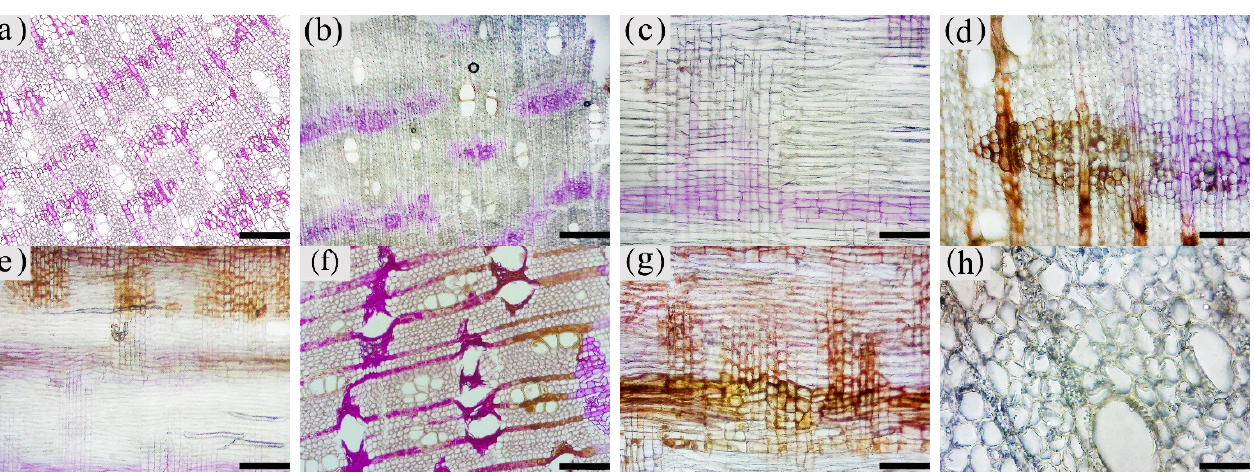
Forests 2022 , 12 , x FOR PEER REVIEW 11 of 20